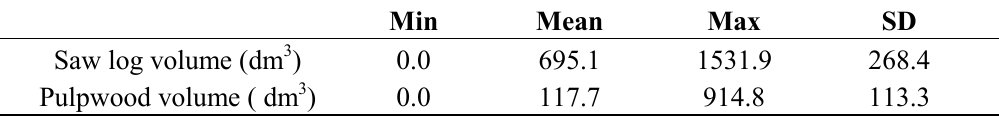
Table 2. Description of the sample trees measured and cut with a